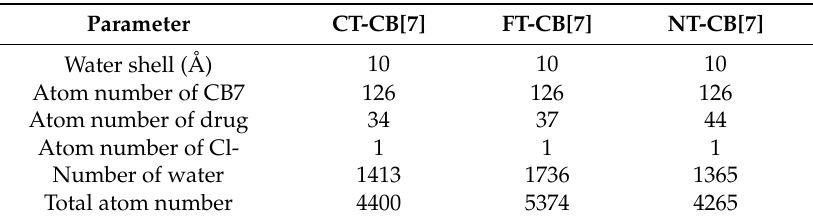
Table 3. Simulation settings of the